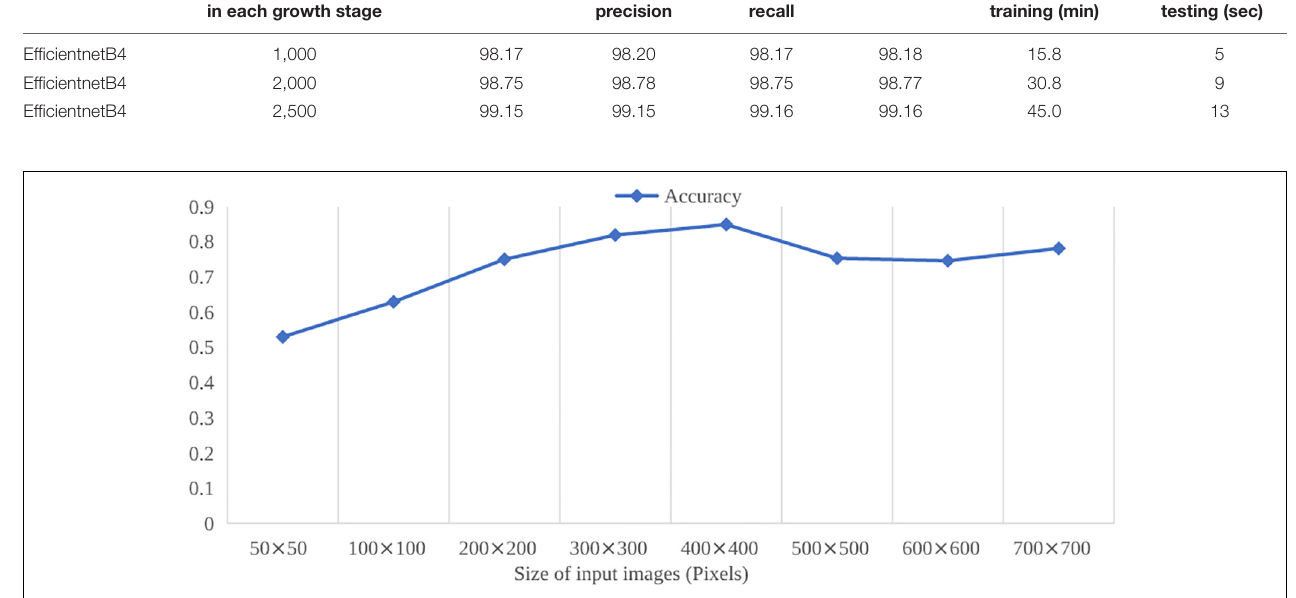
FIGURE 8 | Effects of different input image size on HOG-SVM